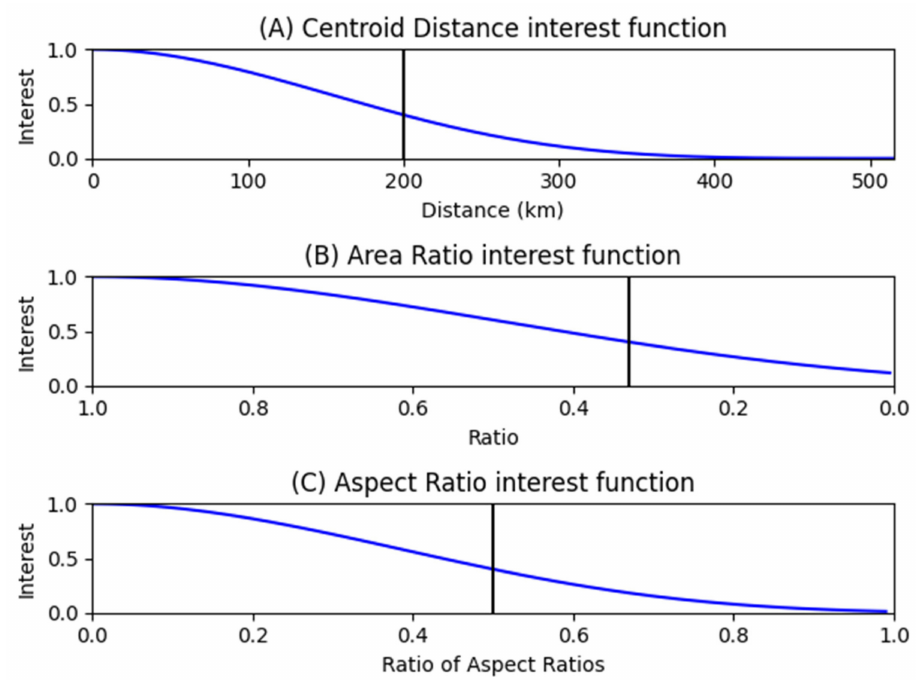
Figure 1. Interest functions to define similarity (i.e., interest) of the ( A ) centroid location, ( B ) area, and ( C ) aspect ratio attributes between two objects. E-folding values are marked by a black